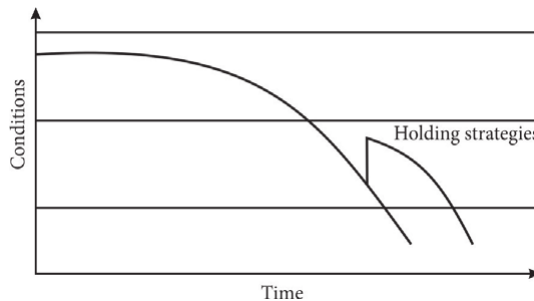
Fig. 10. Strategy of pavement support